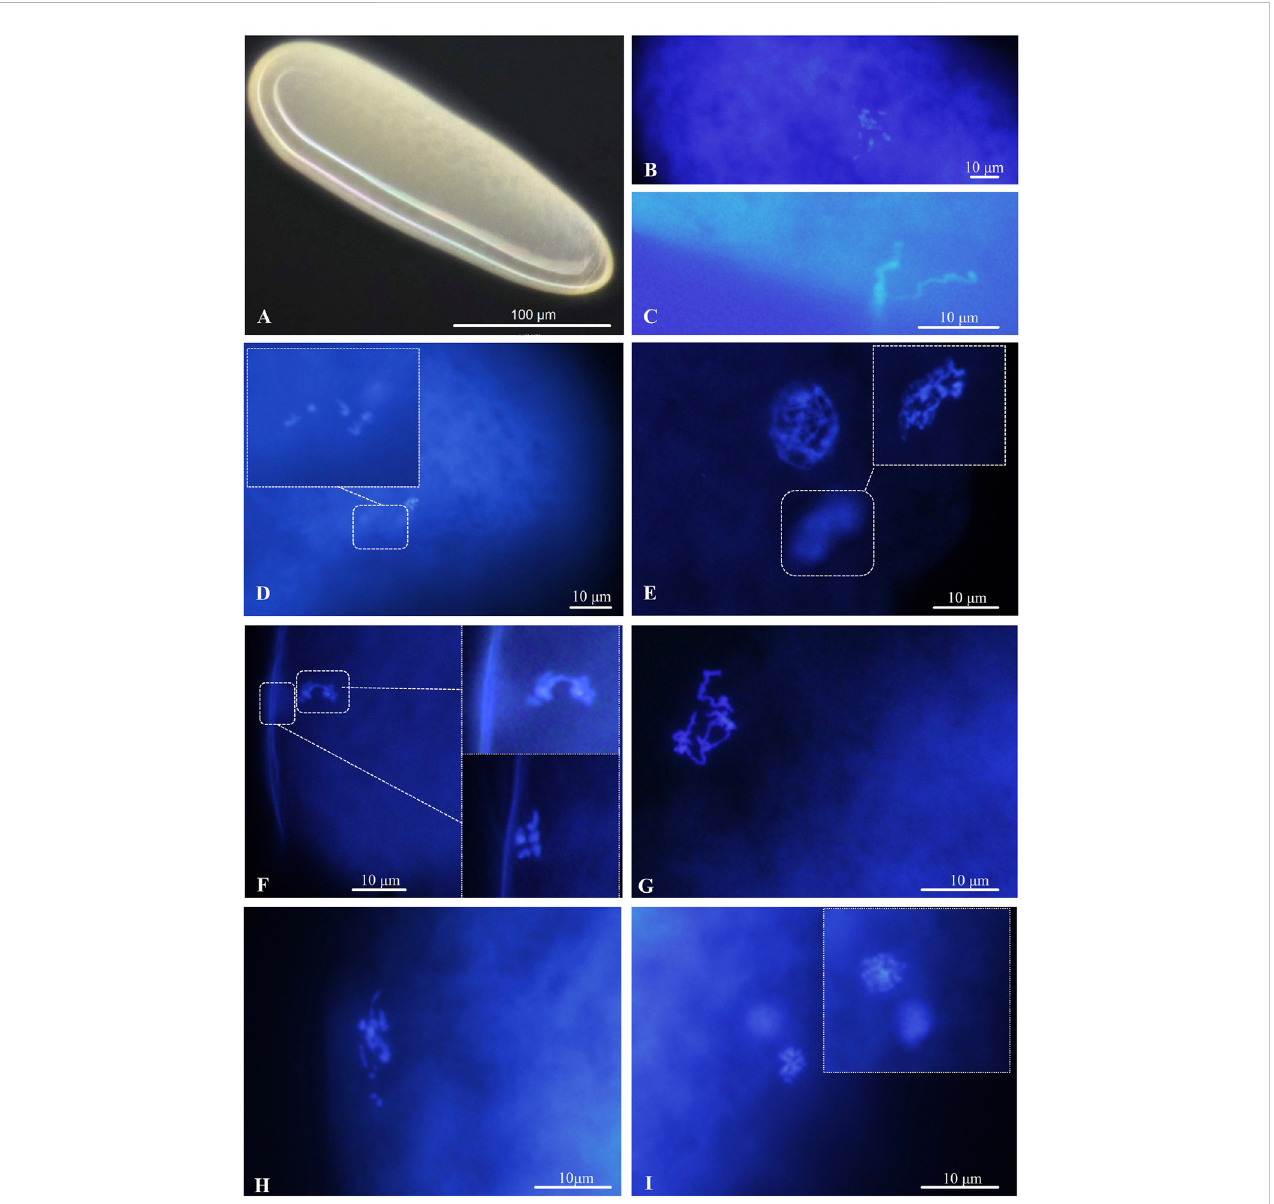
FIGURE 3 Chromosomes in the deposited eggs of the arrhenotokous strain. (A) Egg, creamy white or yellowish white, anterior at the top; (B) First metaphase of meiosis after oviposition; (C) sperm, found in freshly laid and sectioned eggs; (D) fi rst anaphase of meiosis; (E) prophase of second meiosis; (F) second anaphase of meiosis and the fi rst polar body with 5 chromosomes delayed at metaphase; (G) despiralized spermatozoon (H) the end of fertilization of female and male pronuclei (I) diploid telophase of fi rst somatic